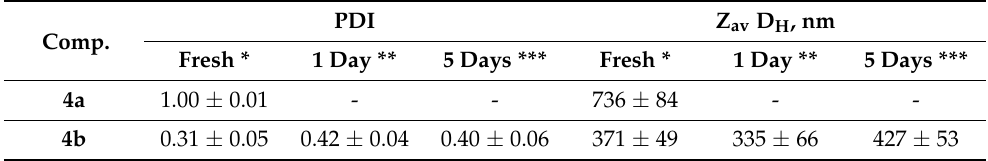
Table 1. Values of polydispersity index (PDI) and Z -average (Z av ) diameter of nanoparticles formed by 3-(3,5-difluoro-3,5-bis((alkoxy)carbonyl)-2,6-dioxoheptan-4-yl)-1-methylpyridin-1-ium